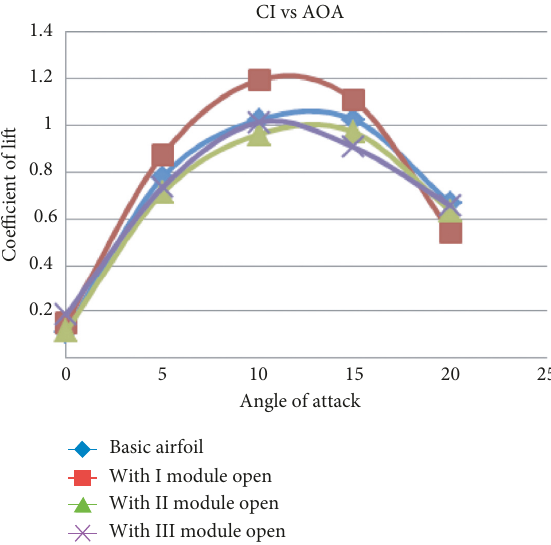
Figure 18: Plot between C